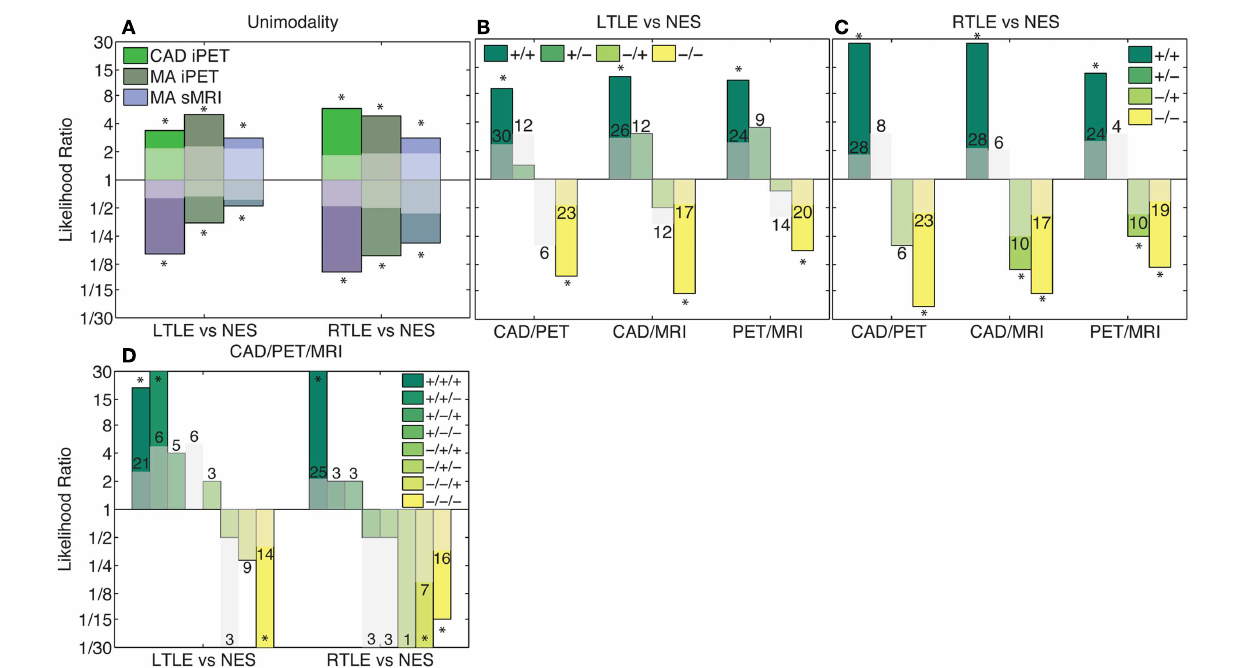
FIGURE 4 | Combination of clinical information and CAD results using likelihoods. Columns in this log plot above 1 indicate that the seizures are more likely to be epileptic whereas the columns below 1 indicate a non-epileptic etiology is more probable. (A) Illustrates the positive and negative likelihood ratio of each analysis method considered individually. (B,C) Illustrate the likelihood ratios of each possible outcome when two analysis methods are combined. (D) Indicates the likelihood ratios of each possible outcome when all analysis methods are combined. If all modalities agree, the likelihood non-significantly increases with the